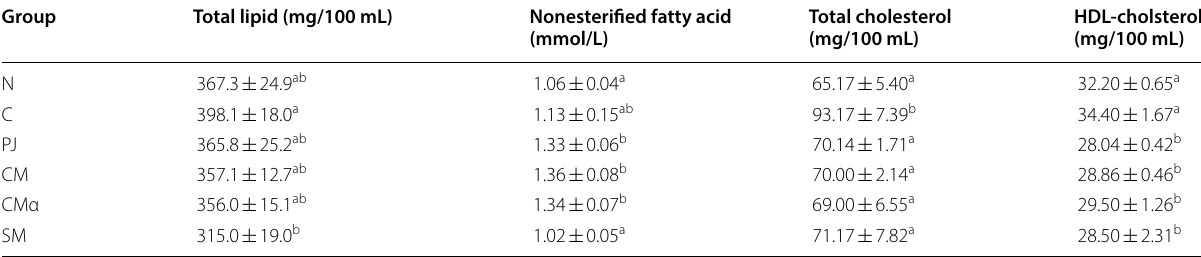
Values are mean S.E. (S.E.: standard error of the mean). Different letters indicate significant differences between the groups ( P < 0.05) ± N, normal; C, control; PJ, Psoroglaena japonica ; CM, Cordyceps militaris ; CMα, cordycepin-rich C. militaris ; SM,